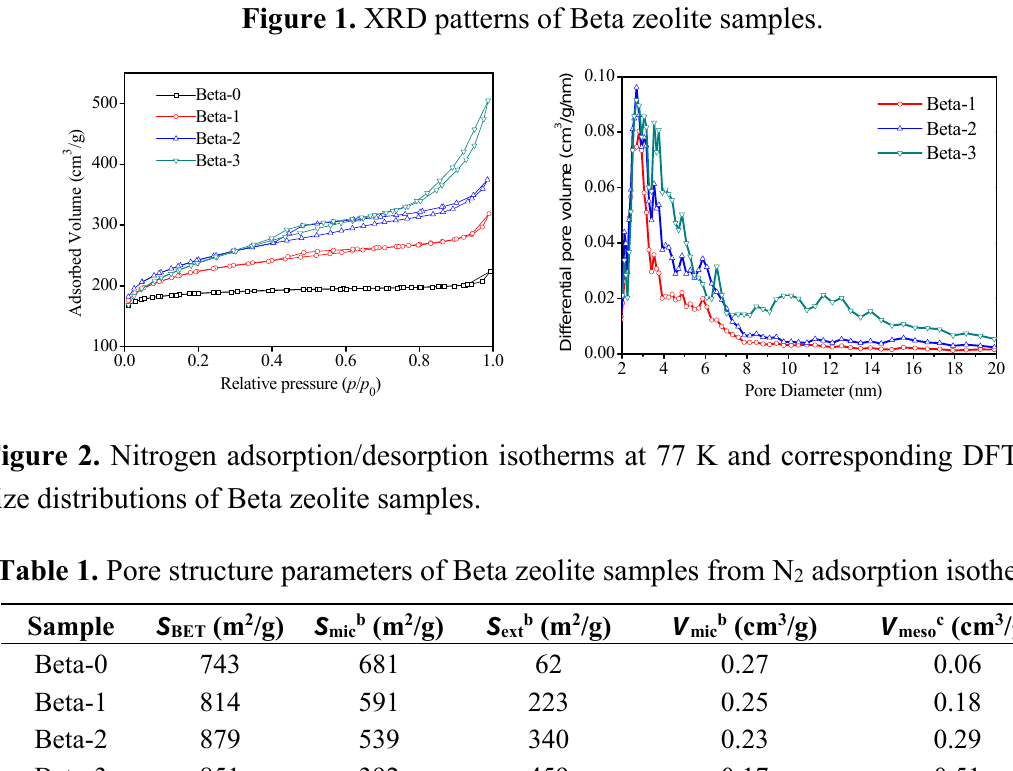
Figure 1. XRD patterns of Beta zeolite samples.